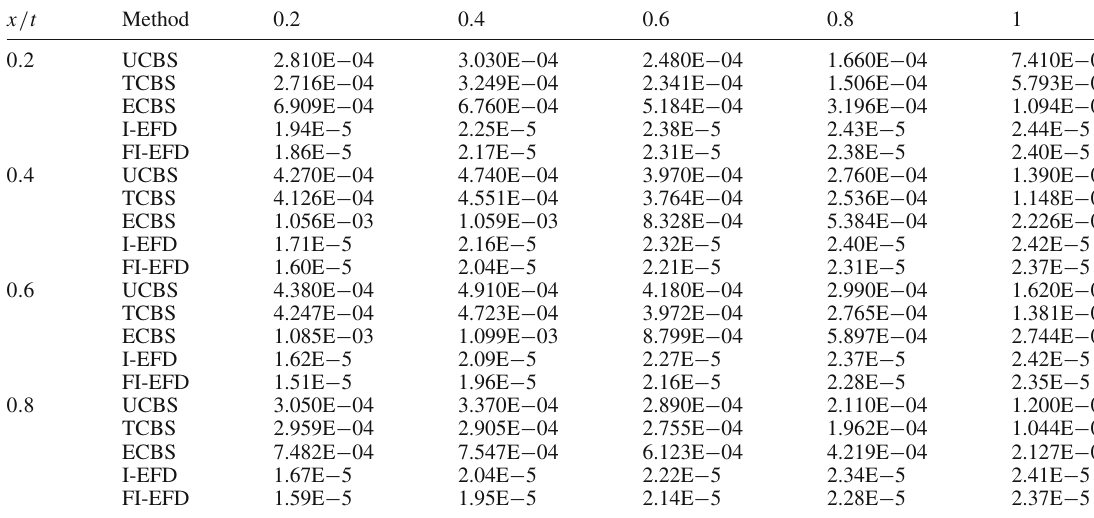
Table 8 L ∞ and L 2 errors of Example 5.3 for (cid:2) x = 0 . 05 and (cid:2) t = 10 − 3 Method t 0 . 01